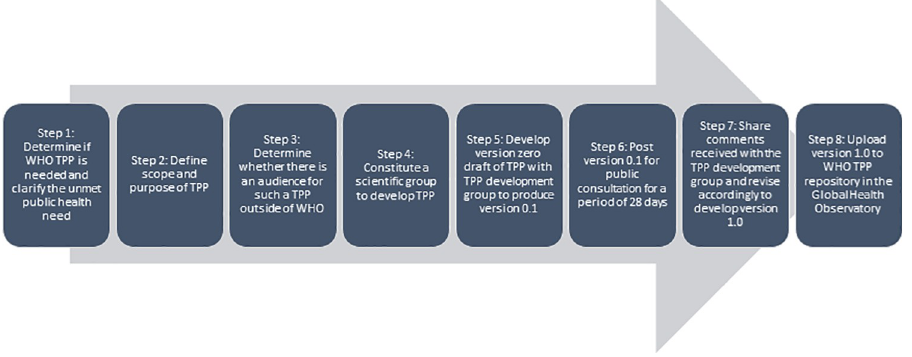
Fig 1. WHO Core TPP